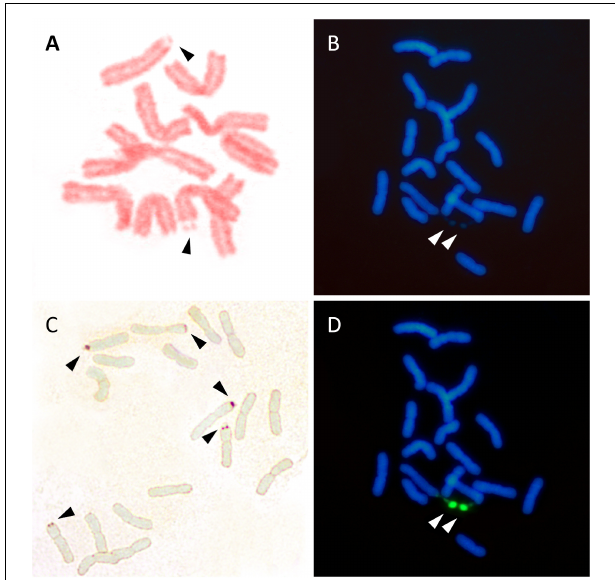
FIGURE 3 | Visualization of 35S rDNA locus using conventional staining (A,B) , silver impregnation (C), and FISH (D) . (A) Lathyrus pisiformis . A single chromosome pair with secondary constrictions after Feulgen staining. (B) Achillea maritima . The presence of two secondary constrictions (arrows) are observed using DAPI staining. (C) Anacyclus homogamos . Five NORs are present after Ag-NOR staining (arrows). (D) Achillea maritima . A single 35SrDNA locus is located on the secondary constrictions after FISH (green